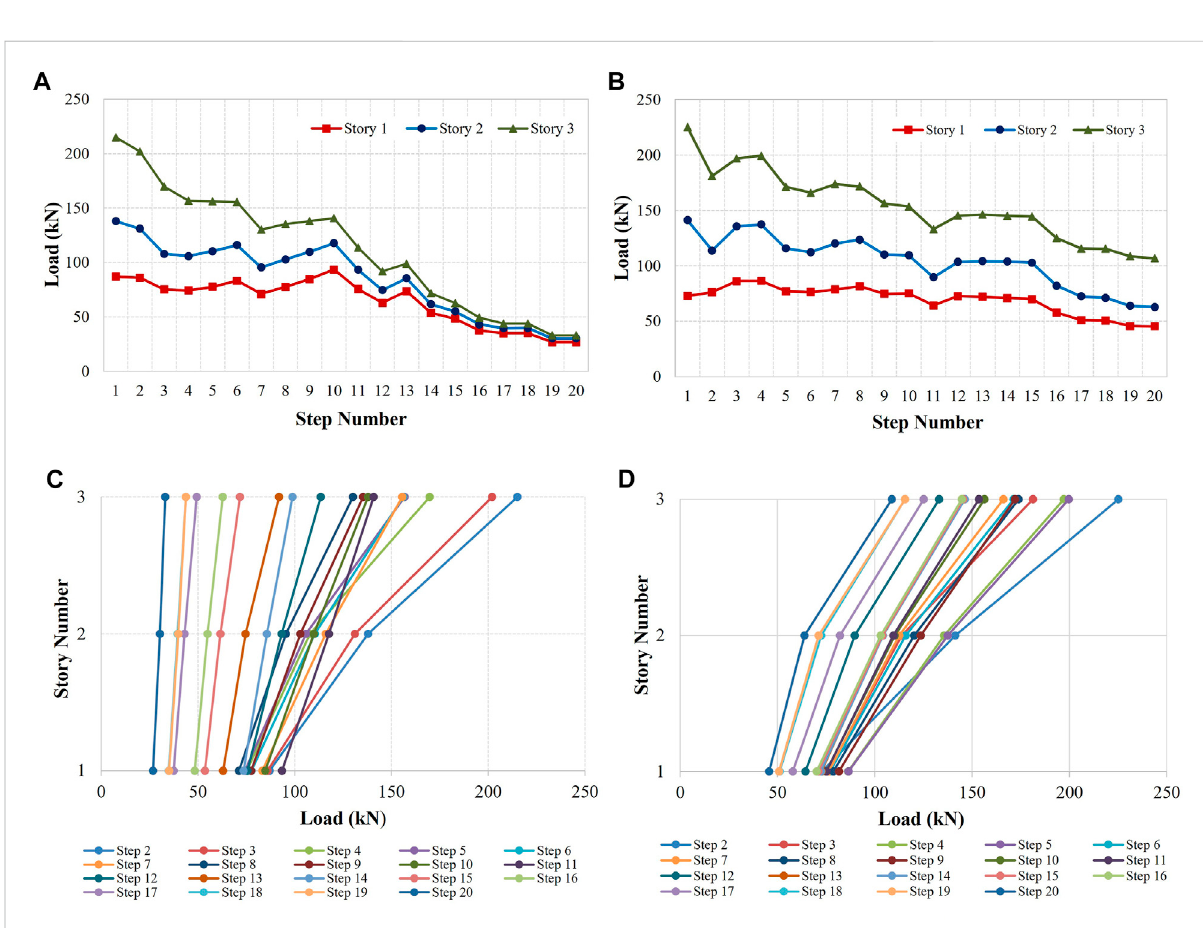
FIGURE 9 Derived load pattern versus step number: (A) x- and (B) y-direction. Height-wise distribution of the load pattern: (C) x- and (D) y-direction.